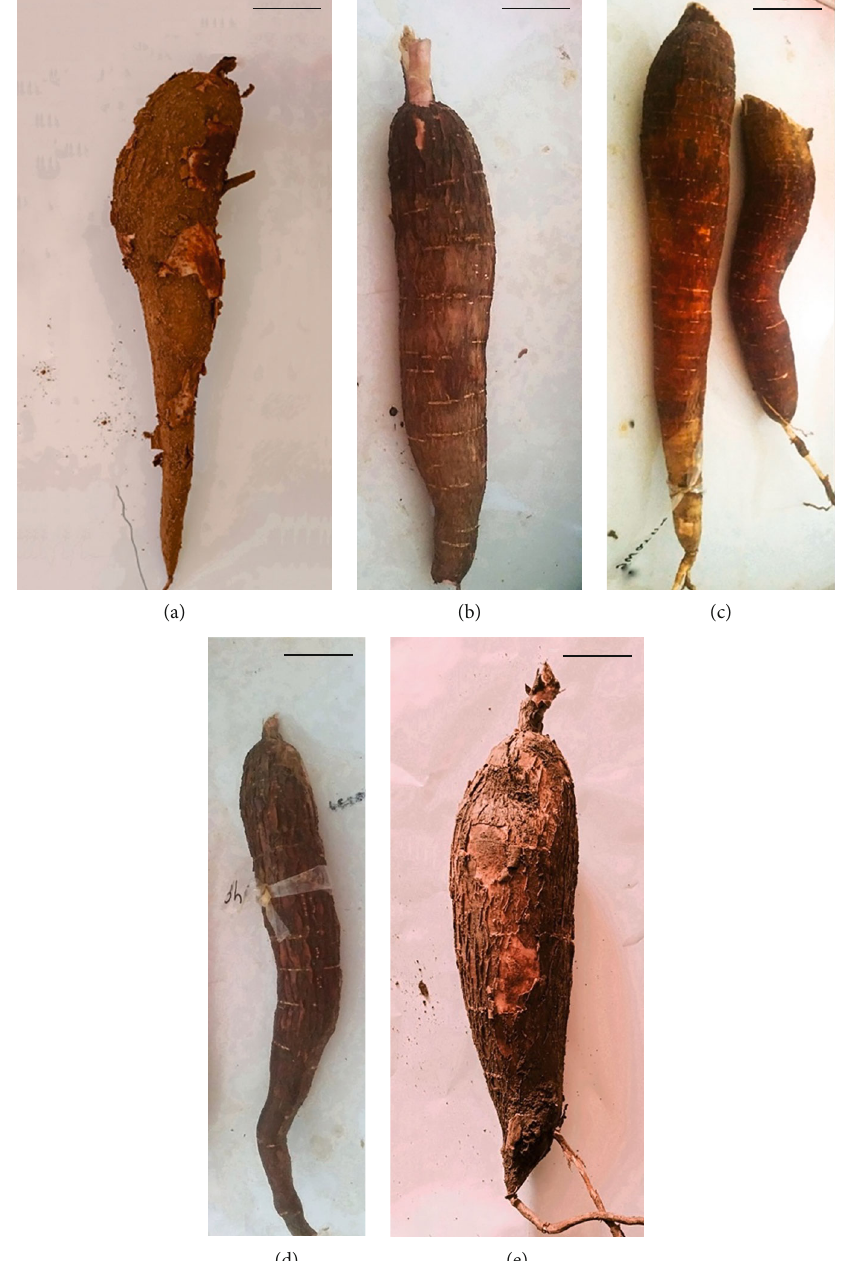
Figure 1: Mature roots of selected Sri Lankan cassava varieties: (a) Kirikawadi , (b) MU51, (c) Swarna , (d) Shani , and (e) Suranimala . Scale bar = 2cm